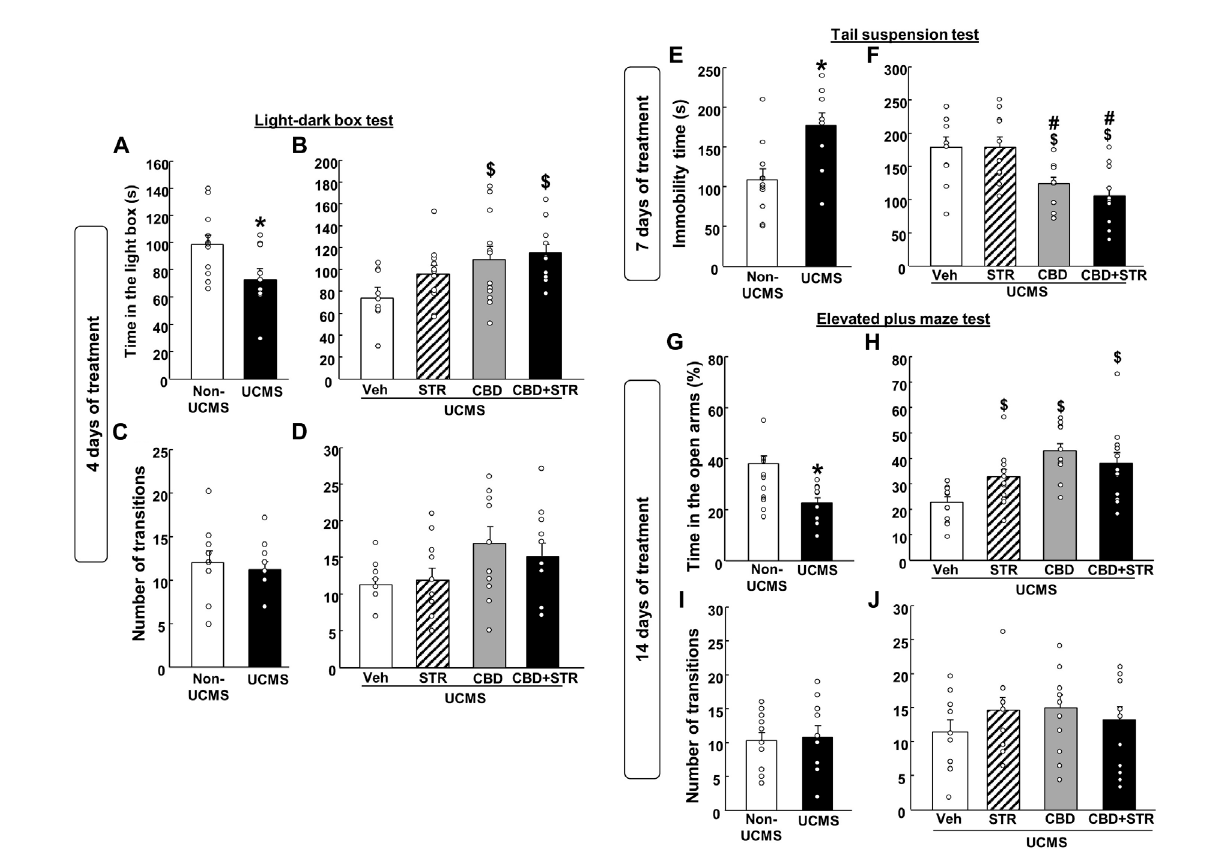
FIGURE 3 Chronic effects of treatment with CBD, STR or their combination in modulating anxiety and behavioral despair in mice exposed to the unpredictable chronic mild stress model (UCMS). Anxiolytic and antidepressant-like effects were evaluated at different time points (4, 7 and 14 days) using the light-dark box (panels A – D ), tail suspension (panels E and F ) and elevated plus maze (panels G – J ) tests. Columns represent the means and vertical lines the ±SEM of each parameter evaluated. *Values from the VEH-treated UCMS group that differ signi fi cantly from VEH-treated non- UCMS group (Student ’ s t-test, p < 0.05). $ Values from STR-, CBD-, and/or CBD + STR-treated UCMS mice that were different from VEH-treated UCMS mice. # Values from CBD- and/or CBD + STR-treated UCMS mice that were different from STR-treated UCMS mice (One-way ANOVA followed by Student-Newman-Keuls, p <